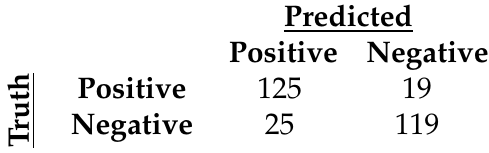
Figure 25. AvgEnsNet 7 confusion matrix.